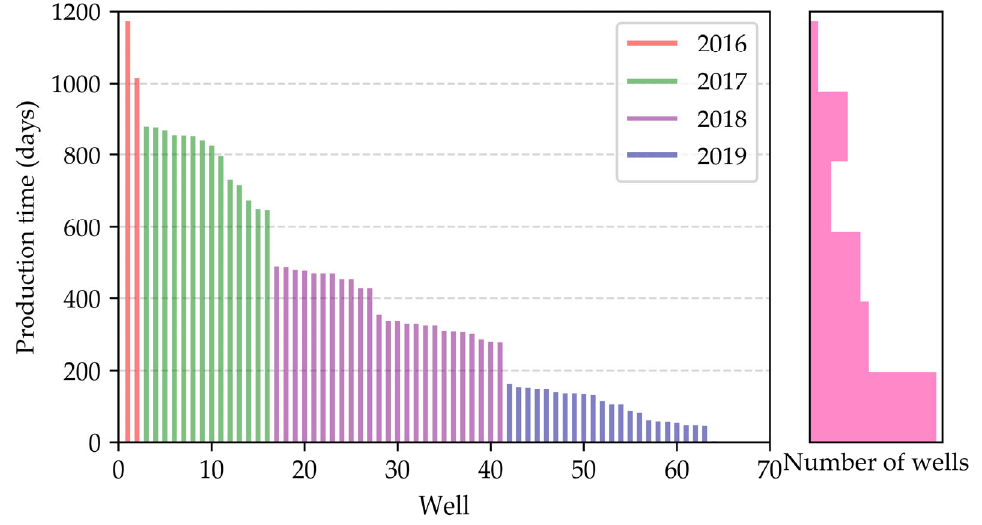
Figure 1. Production time of wells in X well block.